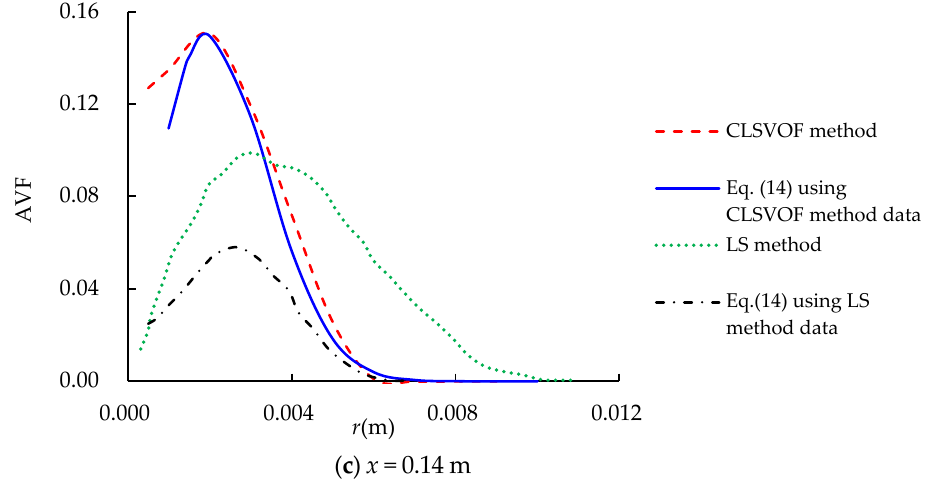
Figure 11. The computational average AVF using the LS and CLSVOF methods with Equation (14) for V 1 = 2.12 m/s and L 1 = 0.025 m at ( a ) x = 0.12 m, ( b ) x = 0.13 m, and ( c ) x = 0.14 m.